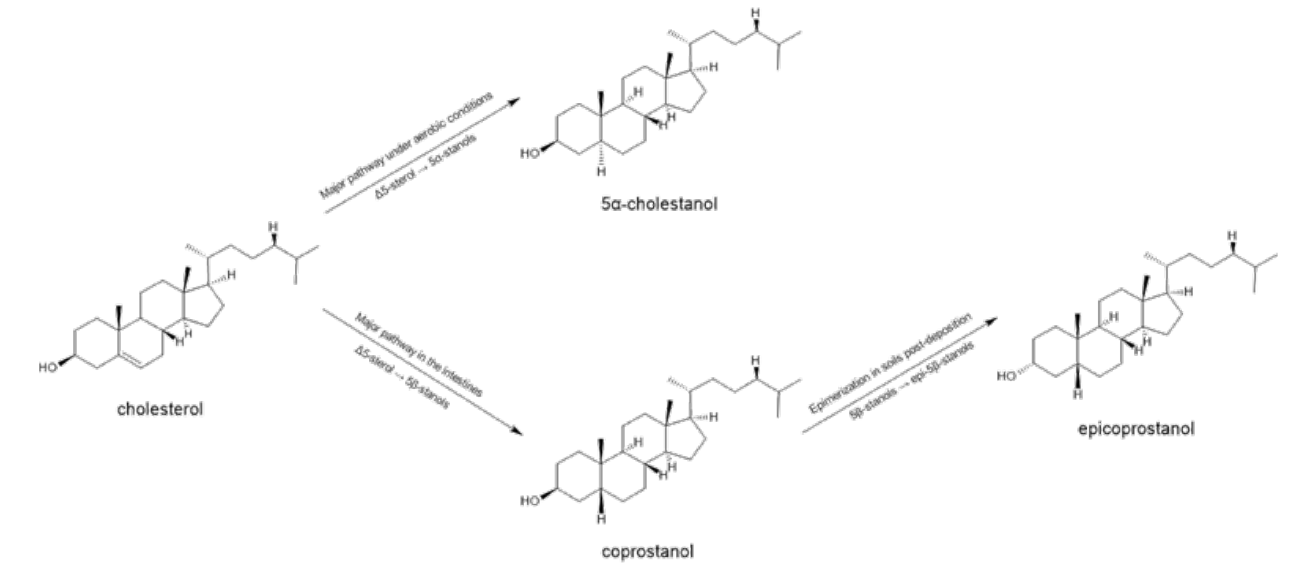
Figure 7. Simplified schematic of the biochemical pathway of the Δ5 -sterol (cholesterol) reduction to 5α -stanols and 5β -stanols in the natural environment and inside the gut (according to Bull et al. 2002 [43], Sistiaga et al. 2014 [24], Prost et al. 2017 [34]).